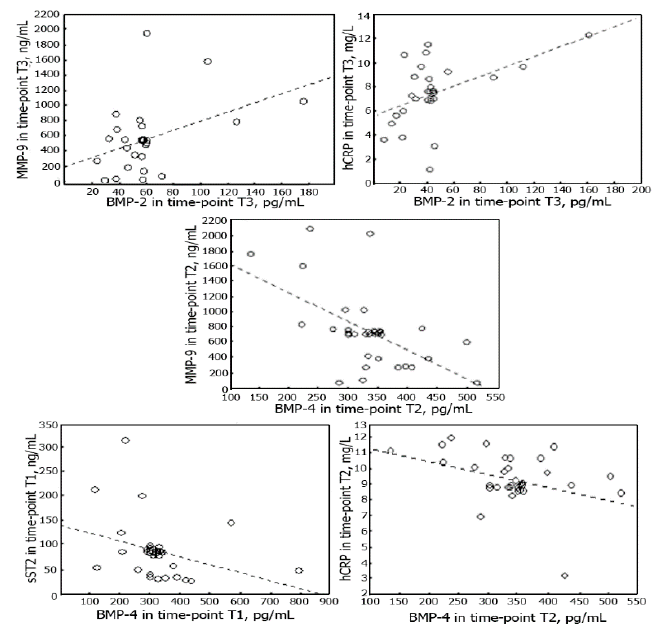
Figure 3. Scatterplots of BMP-2 and BMP-4 and sST2, MMP-9 and hCRP during the 6 months after MI. Spearman’s rank-order correlation: between BMP-2 and MMP-9 (r = 0.5, p = 0.03) and between BMP-2 and hCRP (r = 0.5, p = 0.03) at time-point T3; between BMP-4 and hCRP (r = − 0.6, p = 0.04) at time-point T2 and between BMP-4 and MMP-9 (r = − 0.5, p = 0.03) at time-point T2; between BMP-4 and sST2 at time-point T1 (r = − 0.5, p = 0.03).